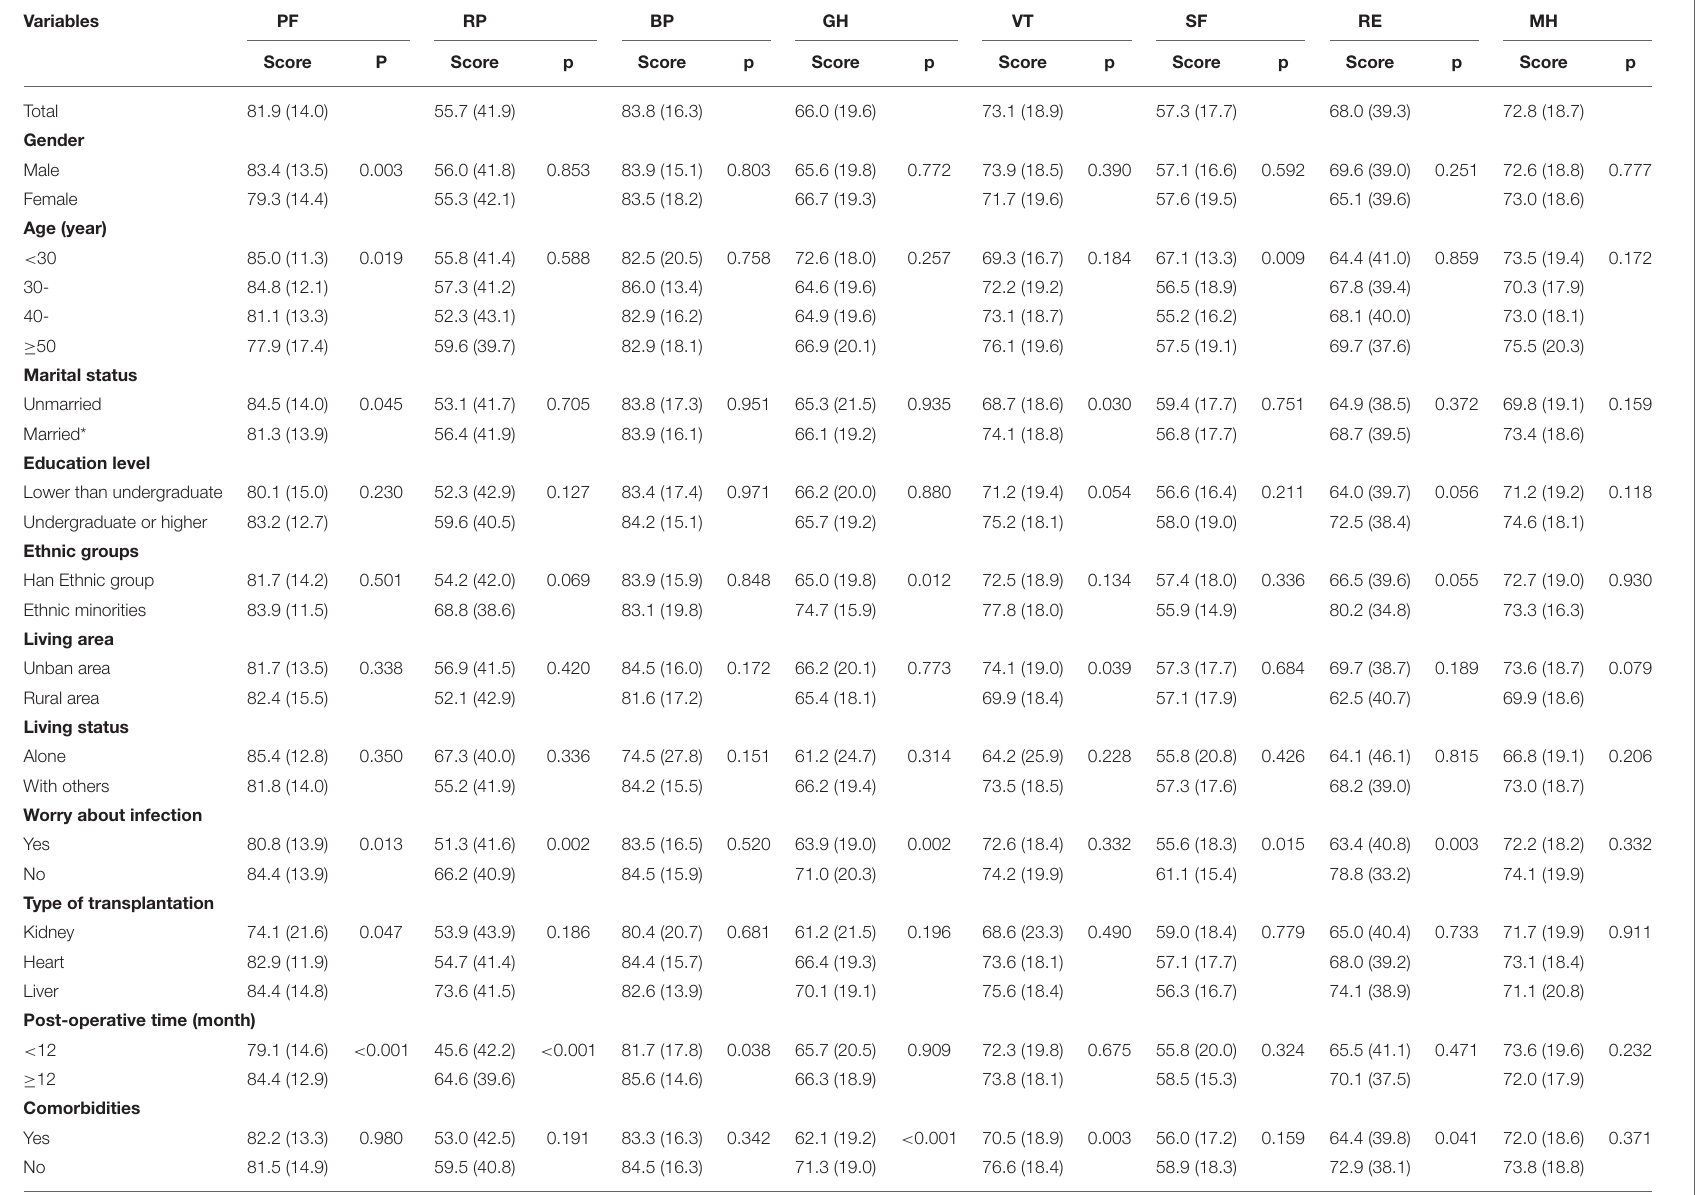
TABLE 3 | Quality of life in organ transplant recipients during COVID-19 pandemic.